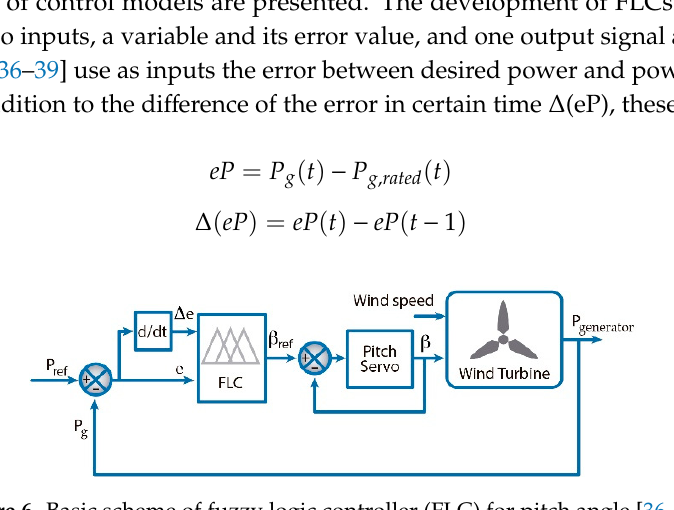
Figure 7. Control strategy with different control loops or different types of controllers, each control signal is added to obtain an equivalent signal [48].